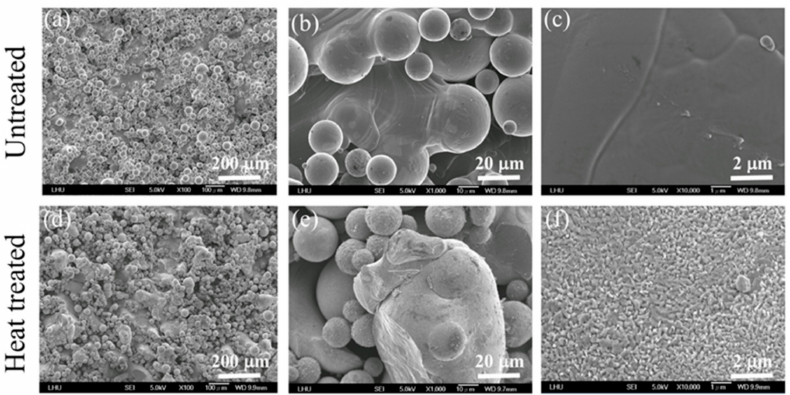
Figure 2. SEM micrographs of untreated and heat-treated Ti64 specimens at different magnifications. ( a , d ) 100 × ; ( b , e ) 1000 × ; ( c , f ) 10 4 ×